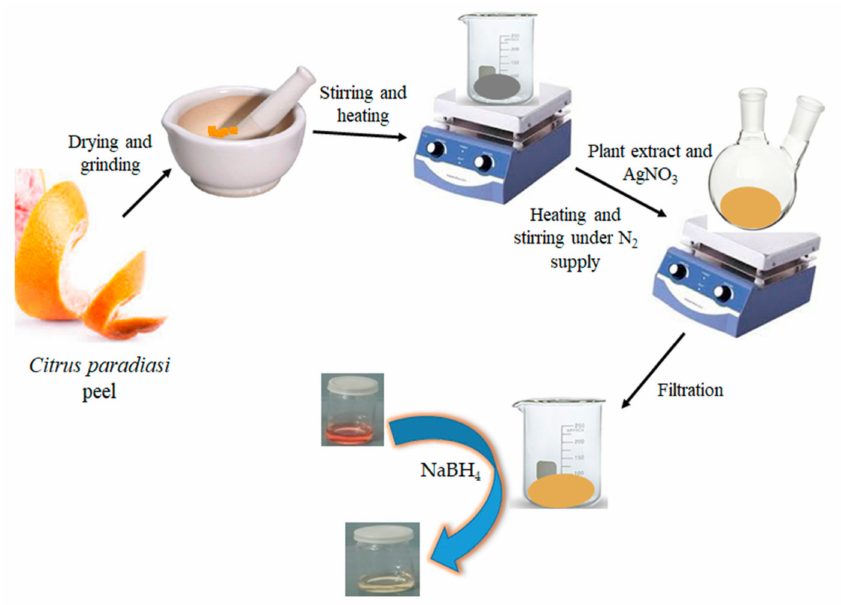
Figure 1. Scheme for preparation of Ag-nPs by the Citrus paradisi peel extract and its use as catalyst for reduction of